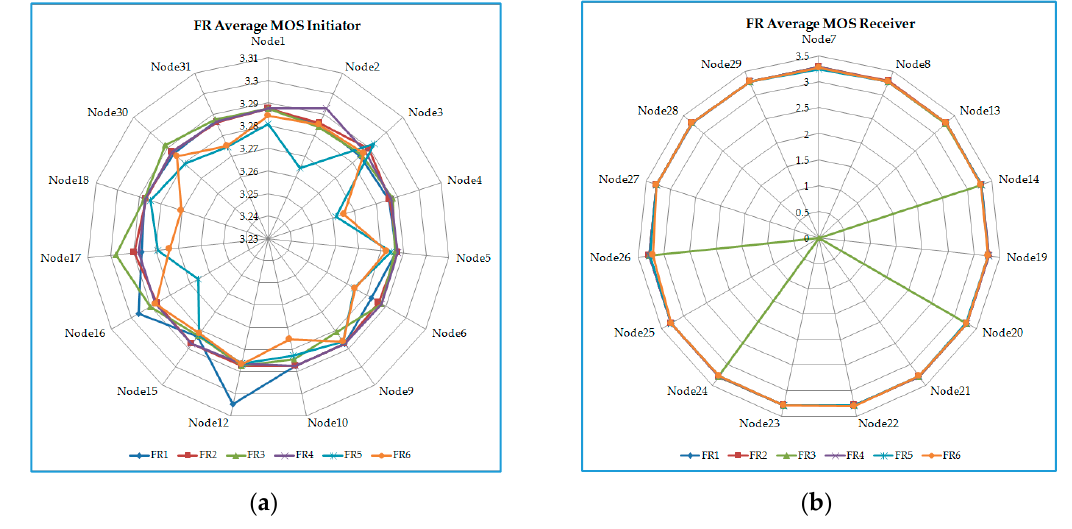
Figure 6. First responders with waypoint mobility MOS values for VoIP initiators and receivers: ( a ) VoIP initiator; ( b ) VoIP receiver.